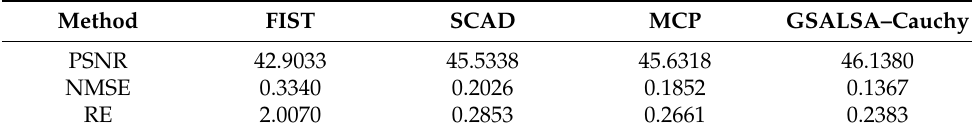
Table 1. PSNR, NMSE and RE of aircraft model with full sampling.